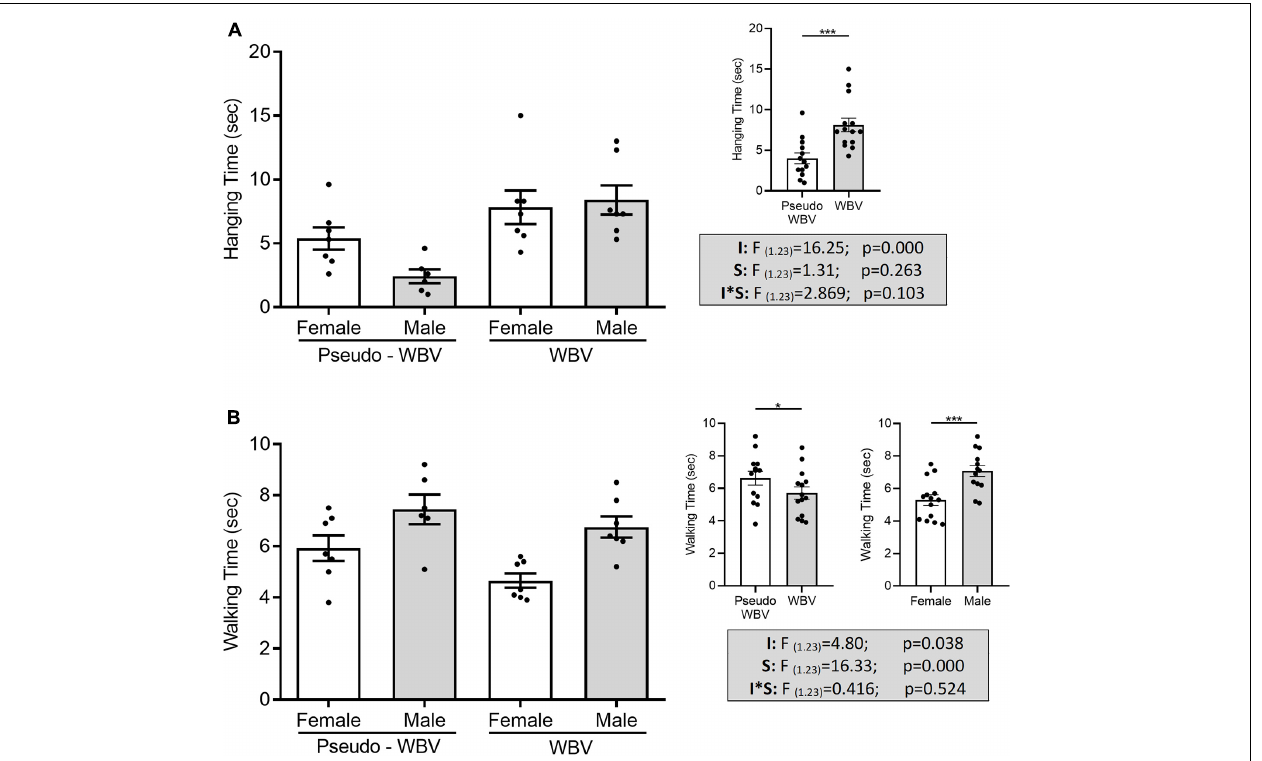
FIGURE 6 | Effects of whole body vibration on motor performance in the grip hanging (A) and balance beam (B) tests. Hanging time was significantly increased in vibration-treated animals compared to the pseudo vibration-treated animals (A) . Walking time on the beam (B) was significantly decreased in vibration-treated animals compared with the pseudo vibration-treated animals, as well in the female animals compared with the male animals. Grip hanging/balance beam: pseudo whole body vibration ( n = 13/13, 7/7 females and 6/6 males) and whole body vibration ( n = 14/14, 7/7 females and 7/7 males). F, F statistical value; I, main effect